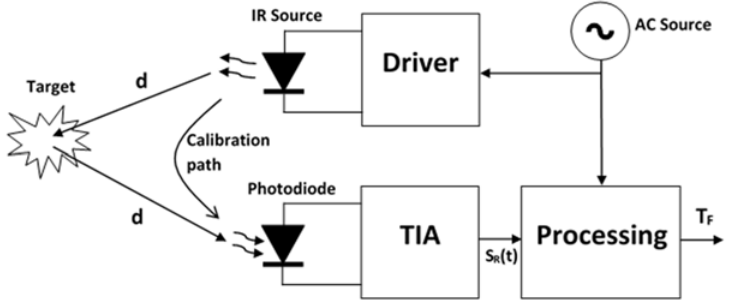
Figure 1. Diagram of optical distance measurement system where emitter and receiver share the same location. Inline recalibration possible through internal calibration path.